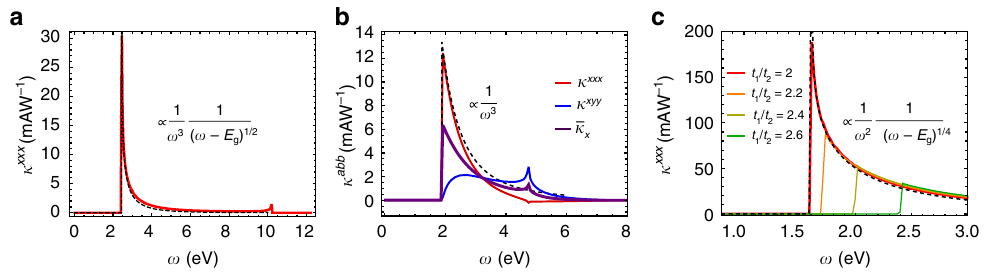
Figure 2 | Frequency dependence of photoresponsivity. ( a ) Responsivity for a stack of disubstituted polyacetylene polymers with tight-binding parameters t 1 ¼ 2.85, t 2 ¼ 2.15, D ¼ 1.0 in eV, showing the square root divergence of the current at the band edges. ( b ) Various non-zero components of the responsivity tensor for a stack of 2D monochacogenides with parameters t 1 ¼ (cid:2) 2.33, t 2 ¼ 0.61, t 3 ¼ 0.13, D ¼ 0.41 in eV and x 0 ¼ 0.52Å. A large peak is observed in k xxx at the band edge. ( c ) Responsivity for D ¼ 0.8eV, x 0 ¼ 0.6Å, t 3 ¼ 0 and different hopping ratios | t 1 |/ t 2 approaching the semi-Dirac limit. The emergence of a singularity is observed. In the three figures, solid lines show the shift current components as computed from the tight-binding model, and a dashed line in each subfigure shows the xxx shift current component as predicted by the effective low energy model valid near the edge equation (9).